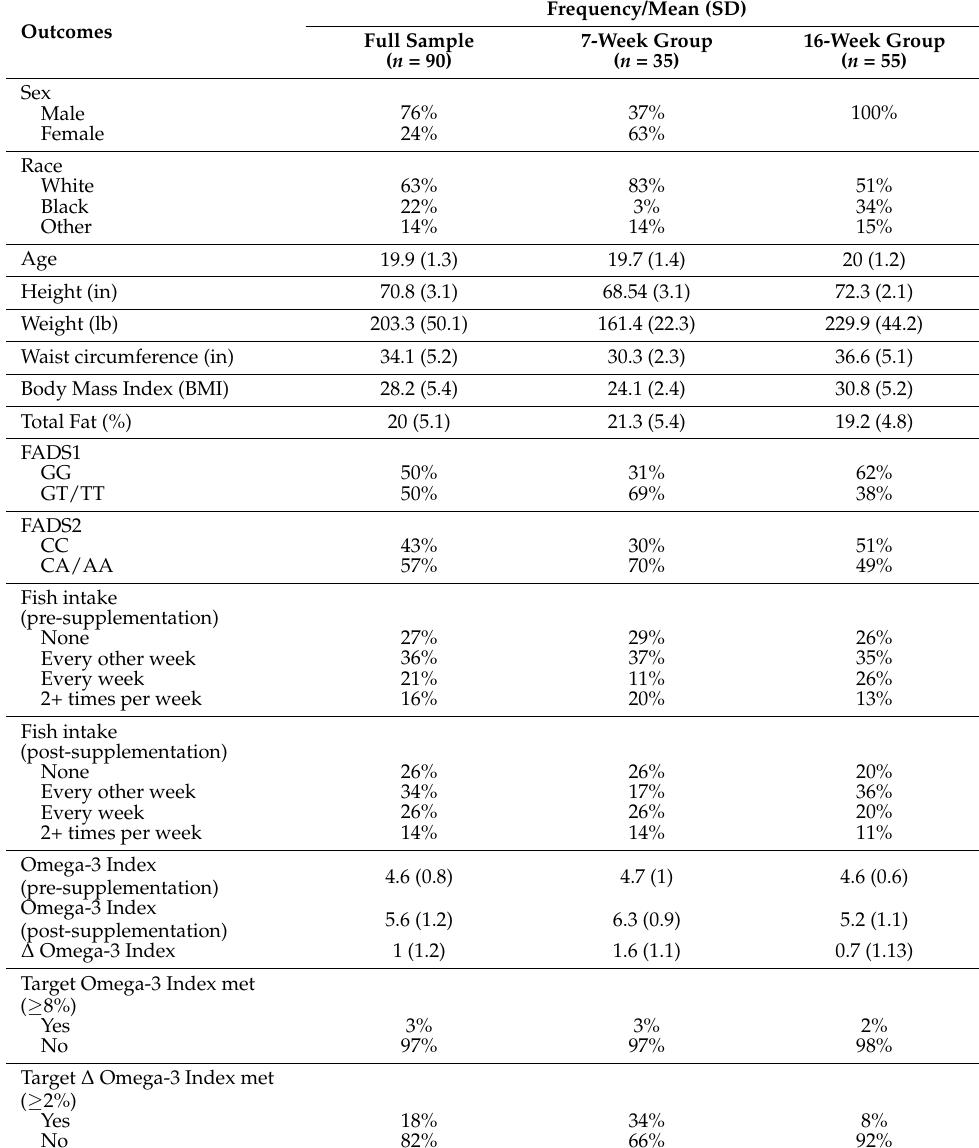
Table 1. Descriptive analyses of the demographics and metrics for the full sample and stratified by supplementation duration (7 weeks and 16